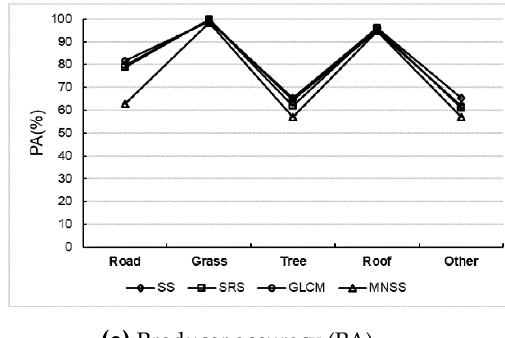
Figure 7. Accuracy assessment by different sampling methods.